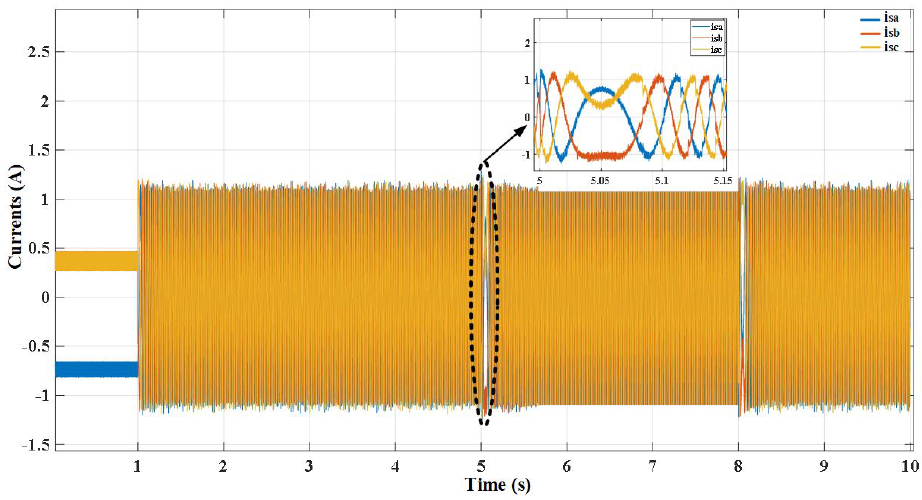
Figure 18. Motor currents of the proposed strategy for nominal